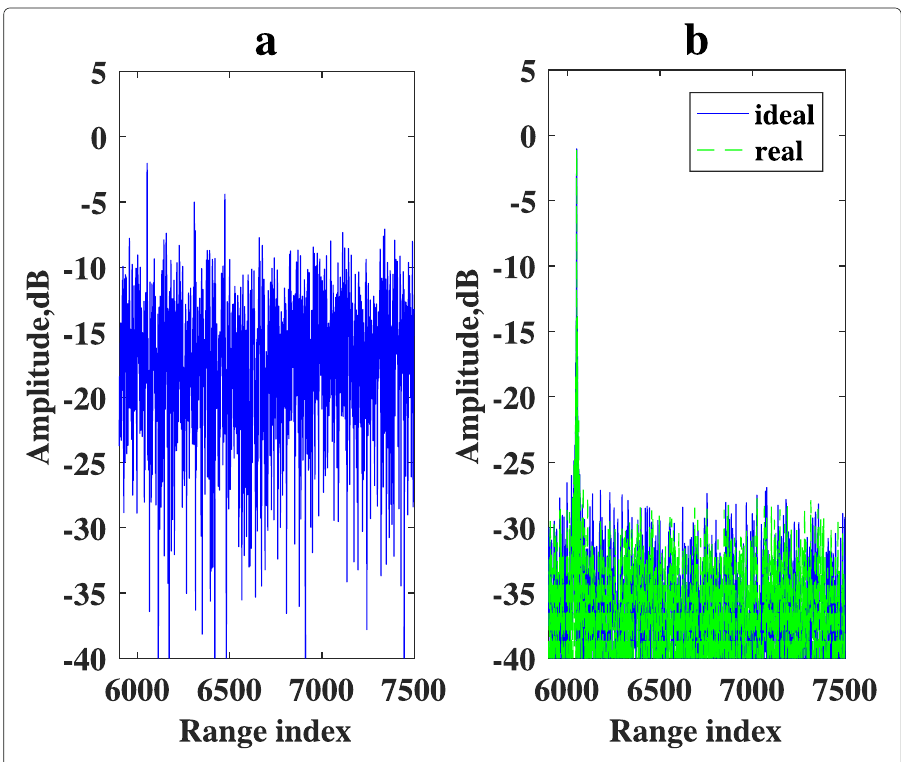
Fig. 2 Contrast between the traditional PC and the proposed algorithm to suppress jamming in the NJ scenario. (SNR = 5 dB, JNR = 20 dB). a Traditional PC . b The proposed algorithm